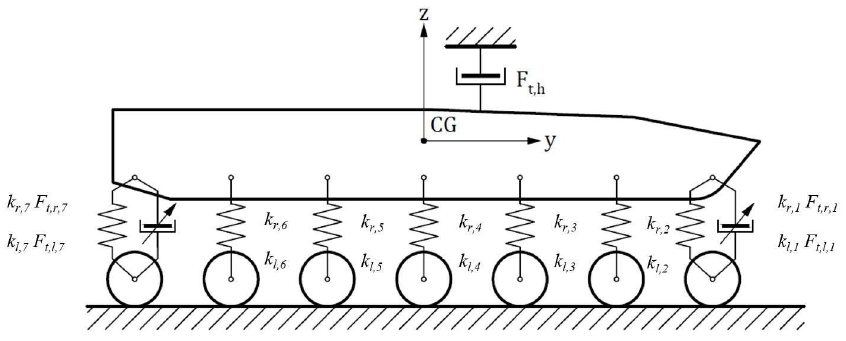
Figure 2. The idea of the abstract linear viscous damper.